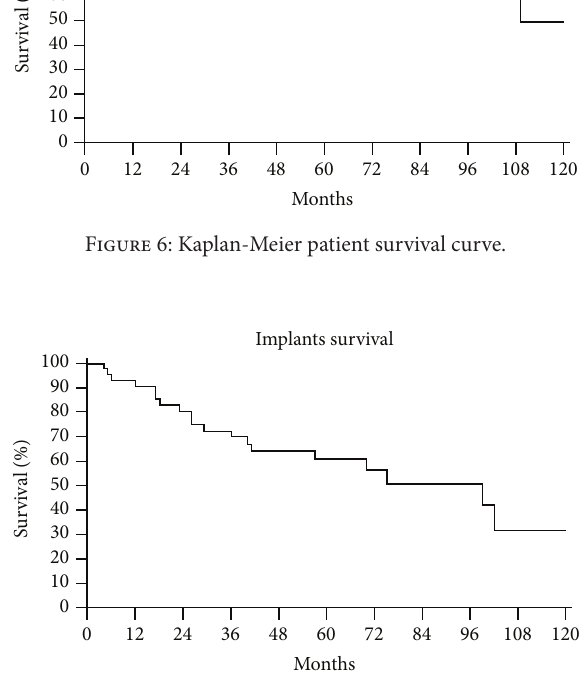
Figure 7: Kaplan-Meier implant survival curve.